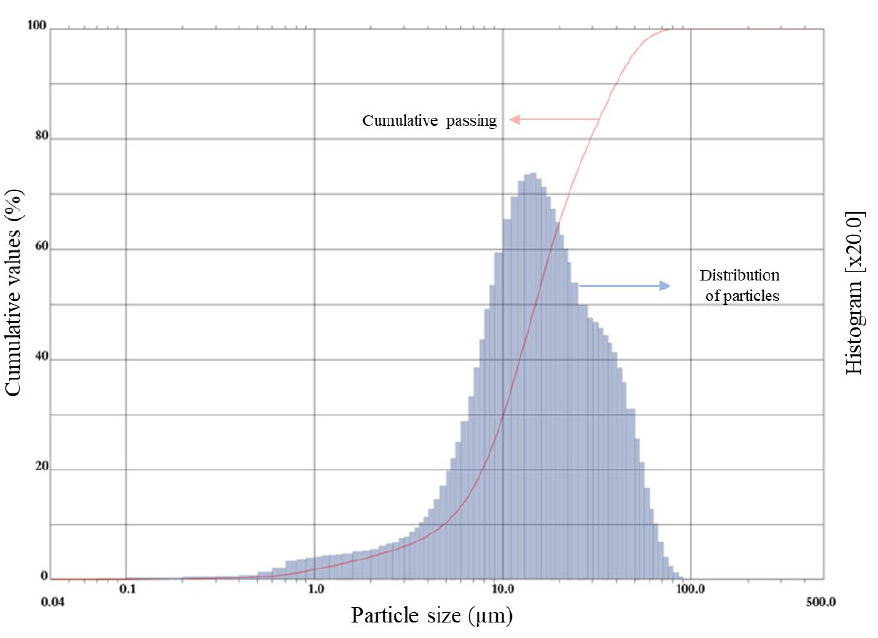
Figure 2. Laser particle size of the